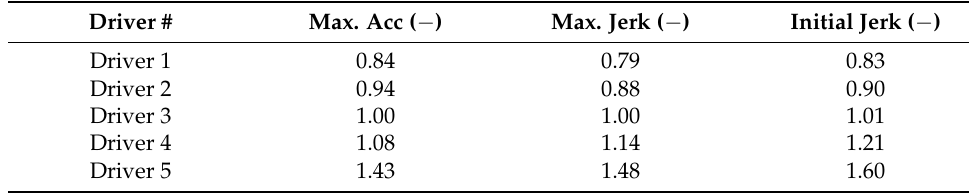
Figure 9. Feature deviation of maximum acceleration.